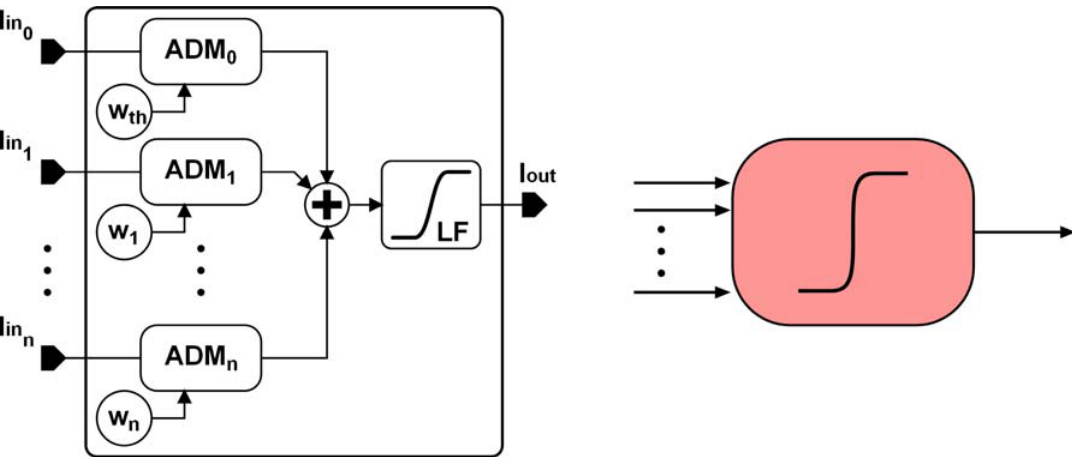
Figure 1. Proposed adaptive processing